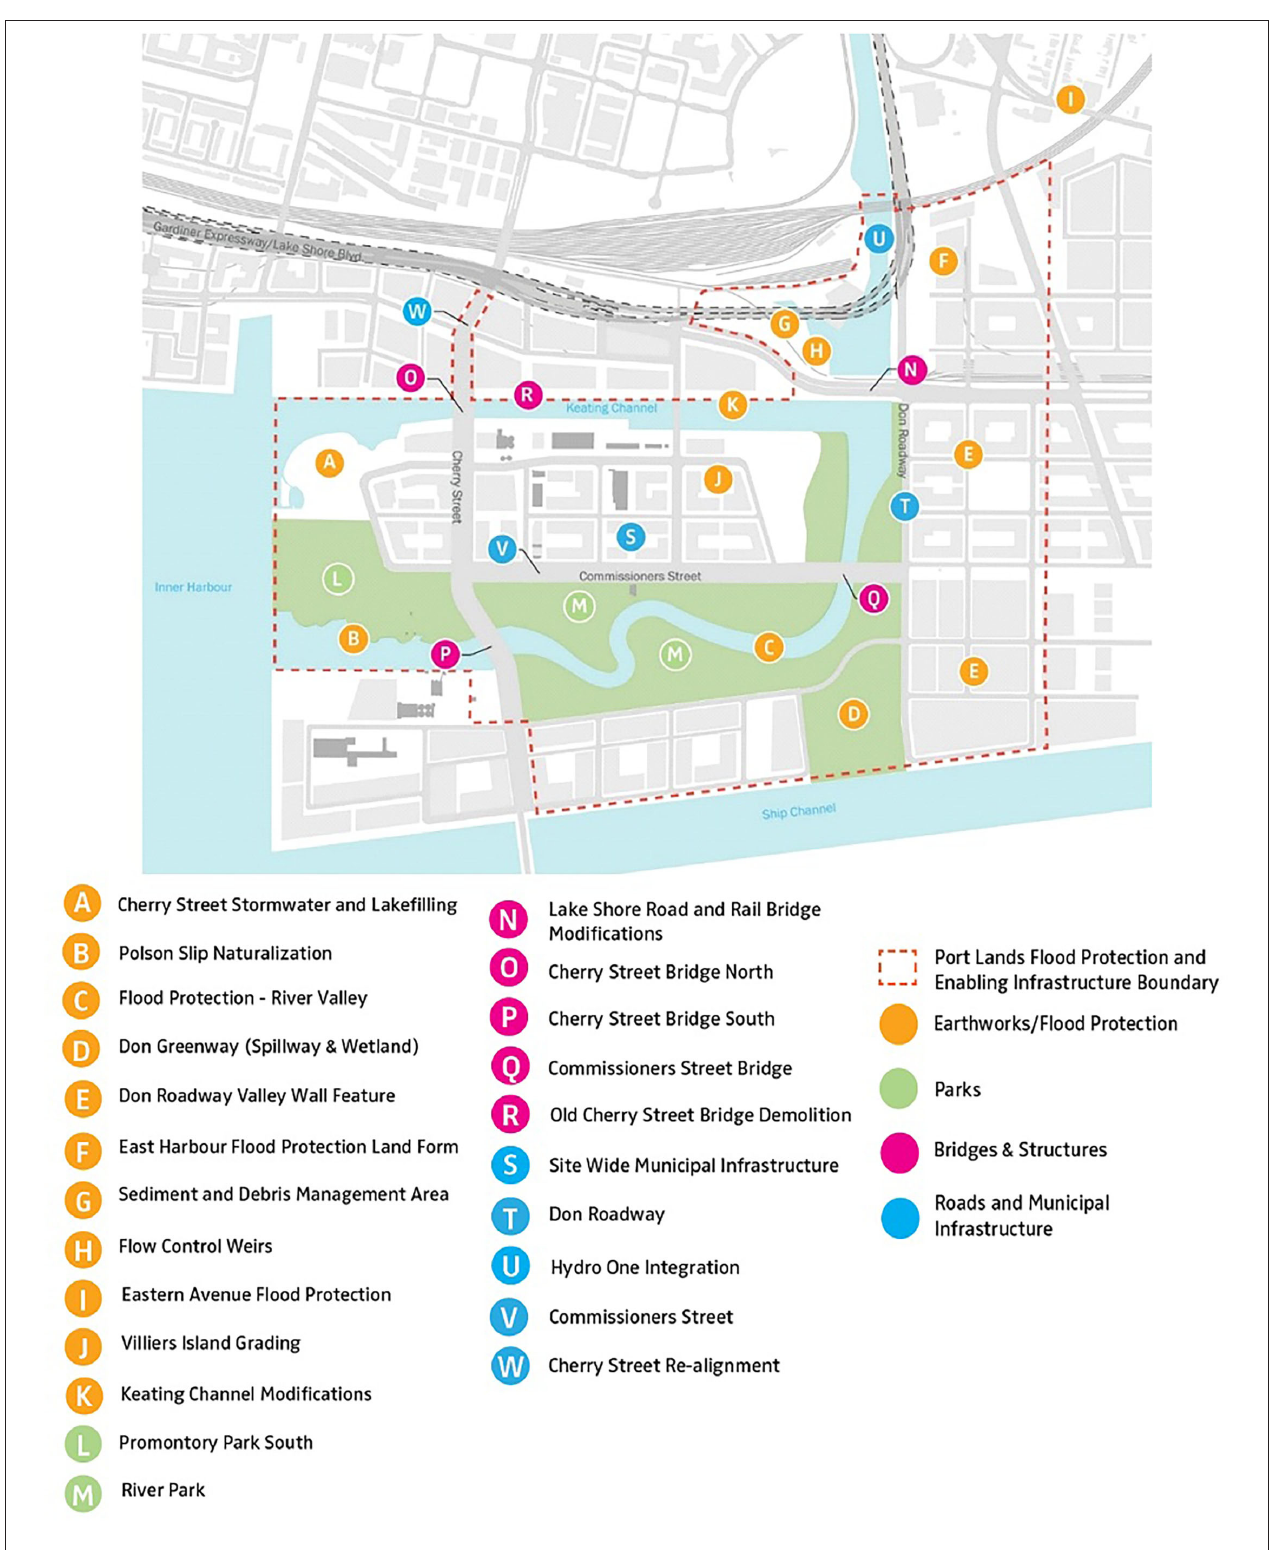
FIGURE 1 | The Port Lands Project for naturalization of the lower Don River (Source: Waterfront Toronto).